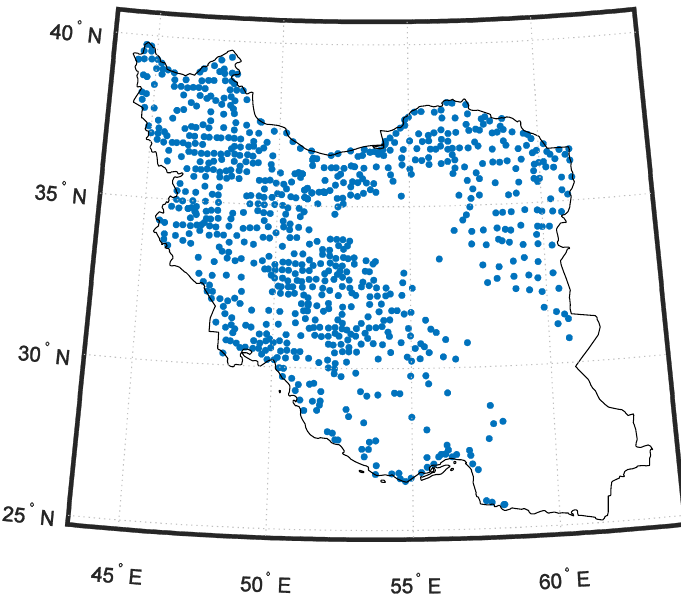
Figure 2 . Geographical distribution of 841 GPS/Levelling points used in this study